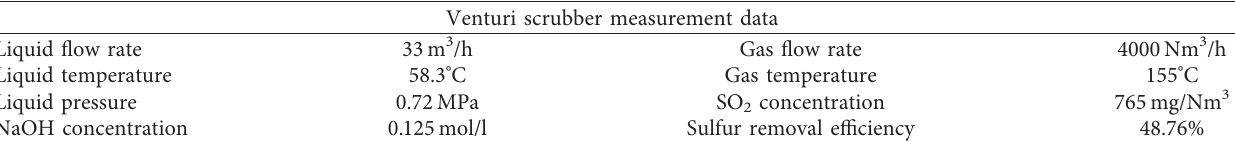
Table 3: Field data of the venturi